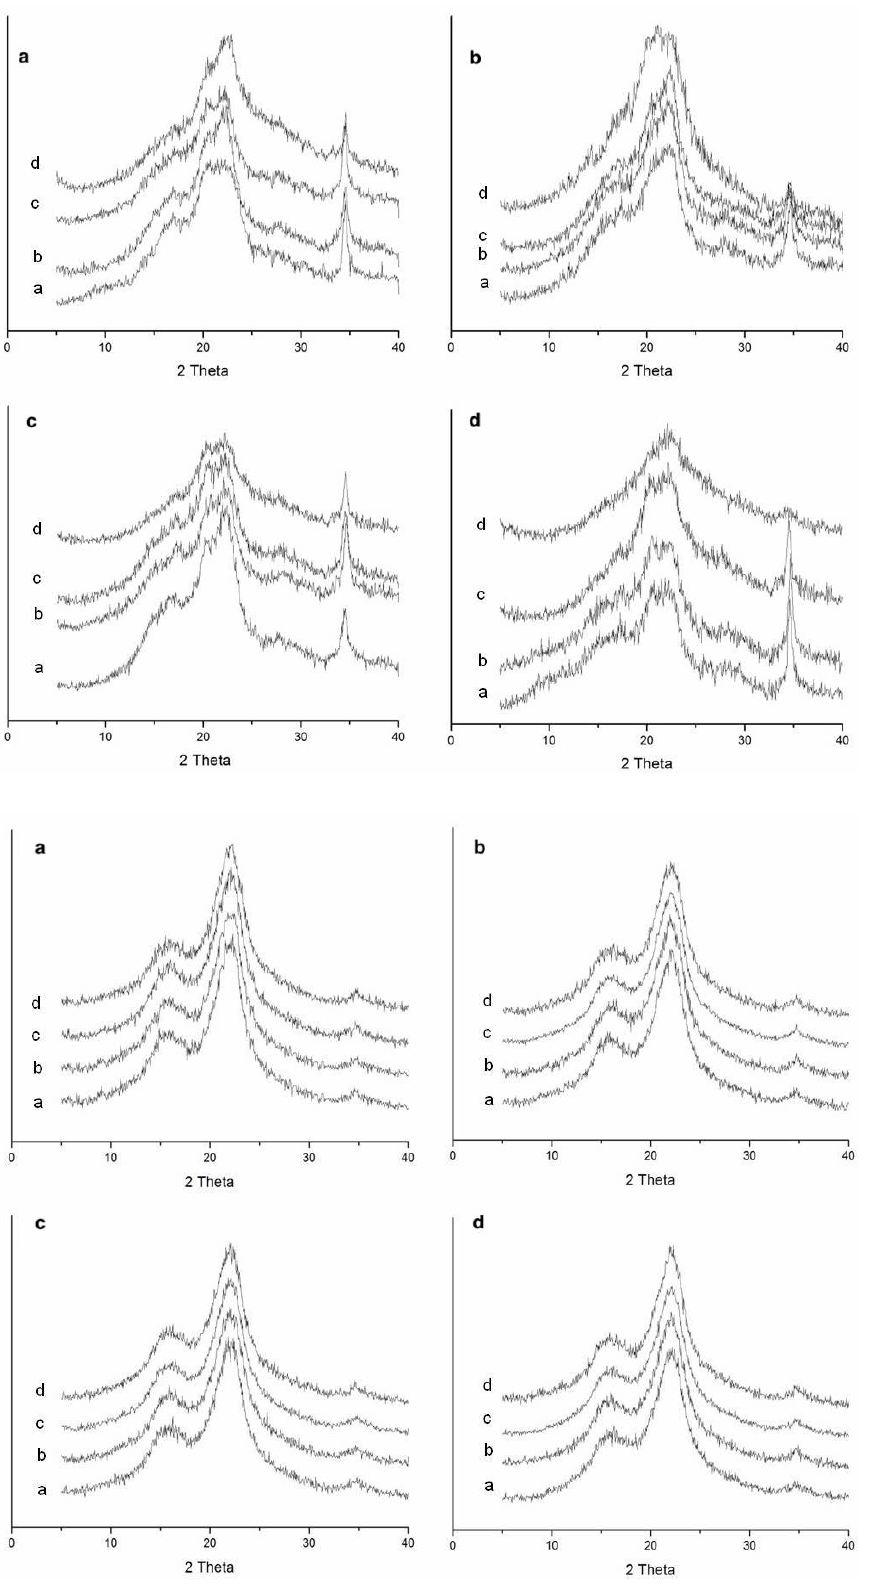
Figure 8. X-ray diffraction analysis of rice hull treated with [bmim][Ac] (a and c), and [bmim][Cl] (b and d), for 2 h (a and b), and 6 h (c and d). Legend: a) untreated